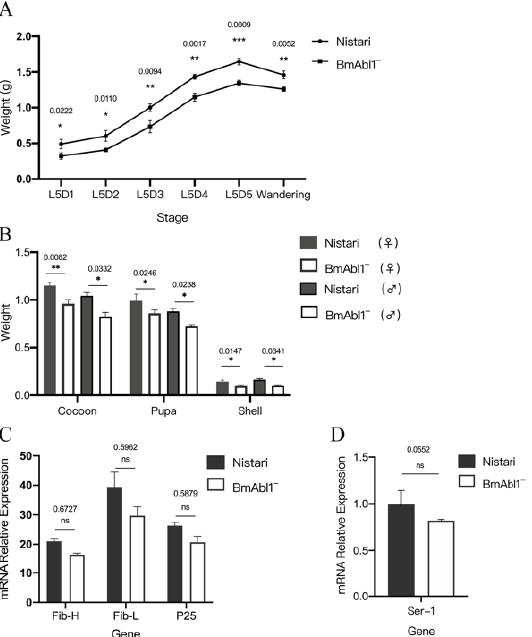
Figure 3. Knockout BmAbl1 led to a reduction of cocoon shell weight (CSW), but not at the transcrip- tion level. ( A ) Larva weight was decreased during the fifth-instar larva of BmAbl1 - strain compared to Nistari; ( B ) cocoon weight, pupa weight, and CSW were decreased in BmAbl1 - strain compared to Nistari, both male and female; ( C ) the expression levels of fibroin heavy-chain, fibroin light-chain, and p25 gene were not different between BmAbl1 - and Nistari ; ( D ) the expression level of sericin 1 was not different between BmAbl1 - and Nistari . Standard deviation was calculated by all biological replicates. * p < 0.01, ** p < 0.005, *** p < 0.001, t -test, n = 30 for Control and n = 30 for Treated; each